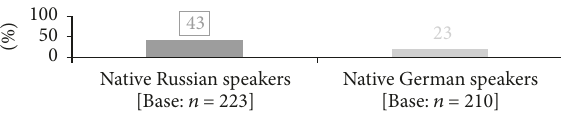
Figure4:Recognitionoftheword« ^]S e»(['pap J 'pi ⎰ J t'polje],Eng.: «Papa writes to Polya»), depending on the characteristics of the speaker.